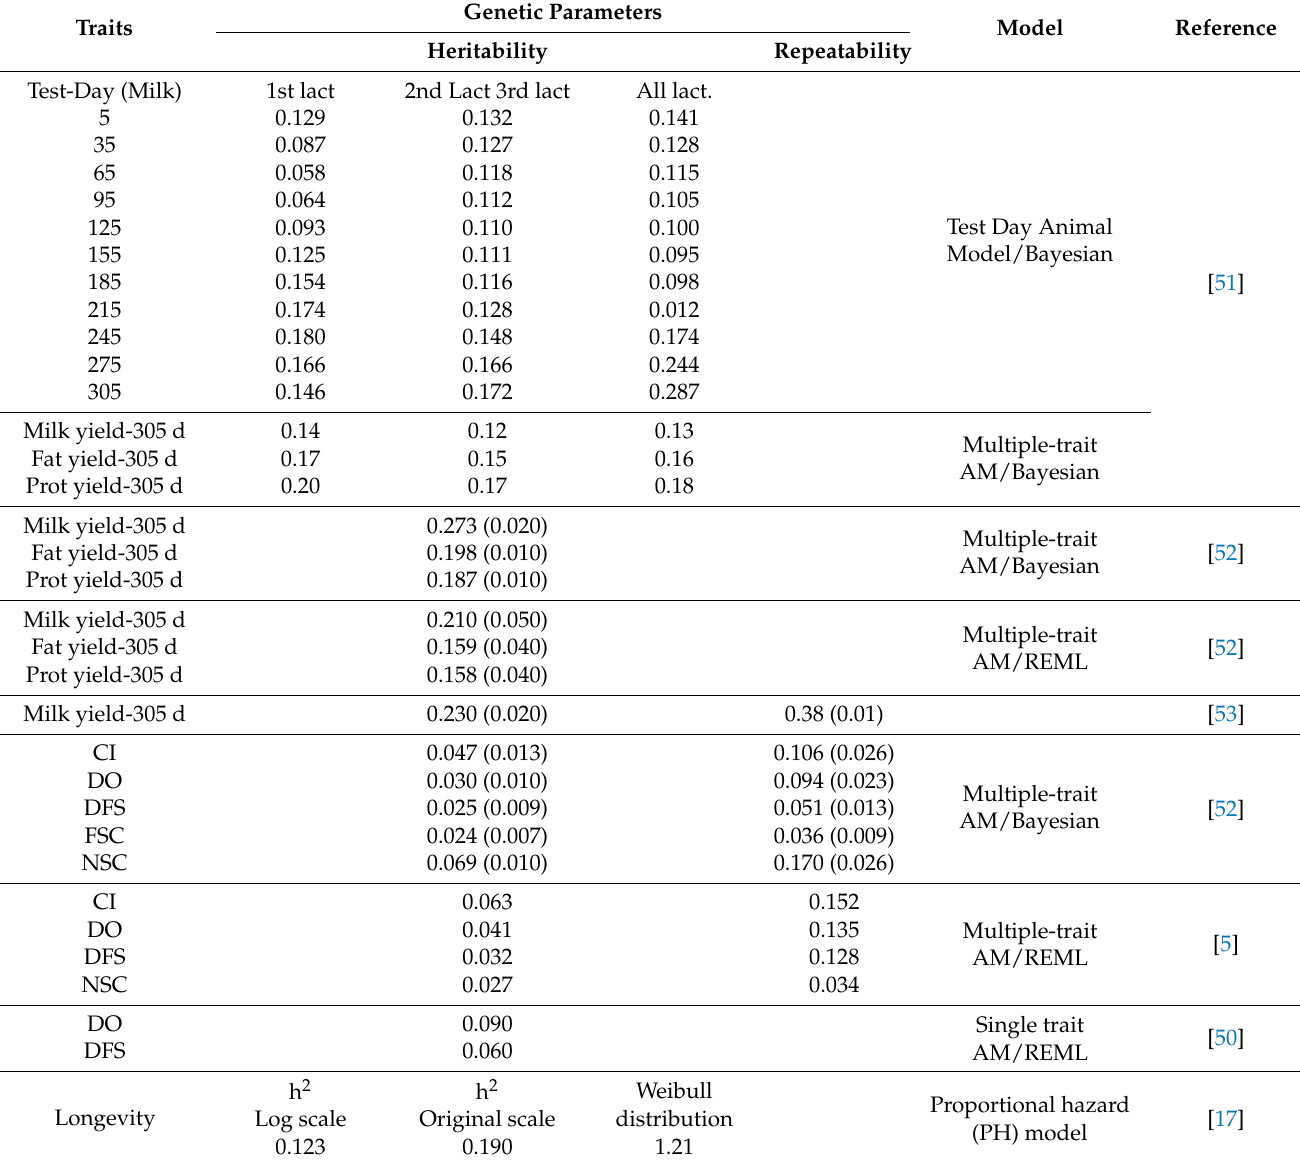
Table 1. Main results on genetic parameters of milk yield, reproduction, and longevity in Tunisian Holstein dairy